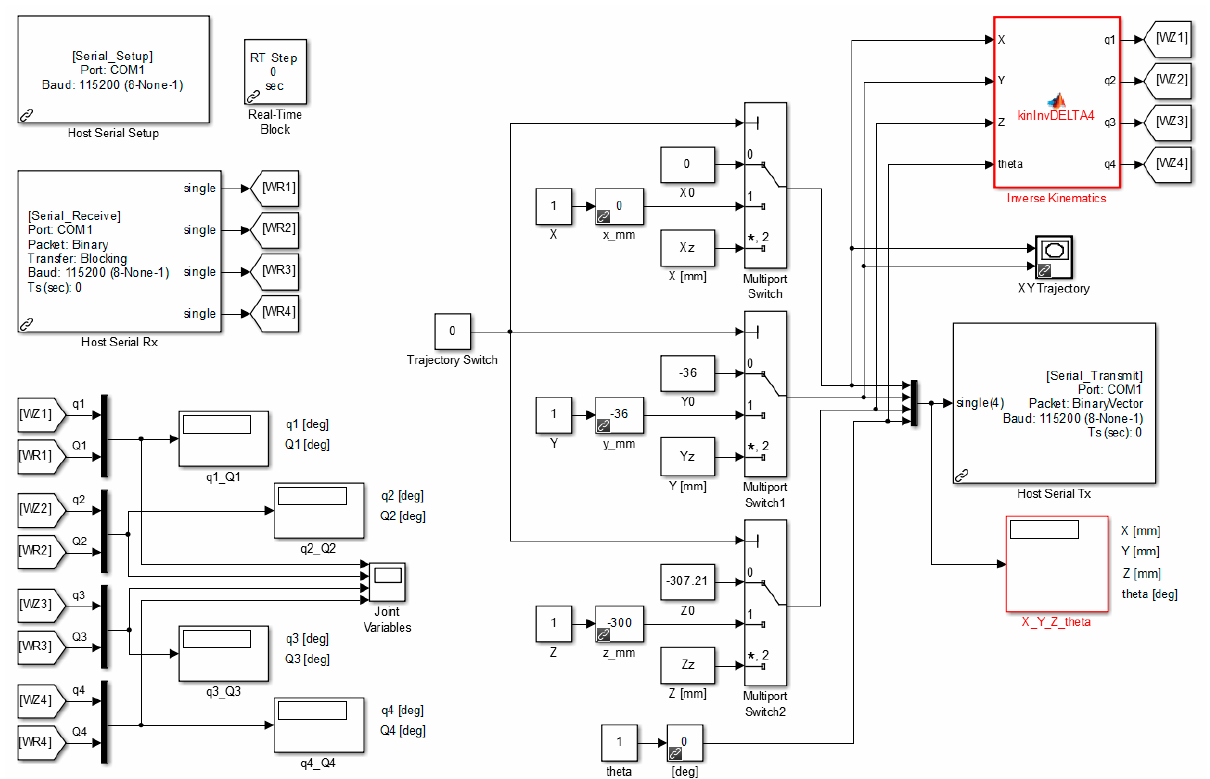
Figure 23. A flow chart of Host_DELTA4.slx in Matlab/Simulink.